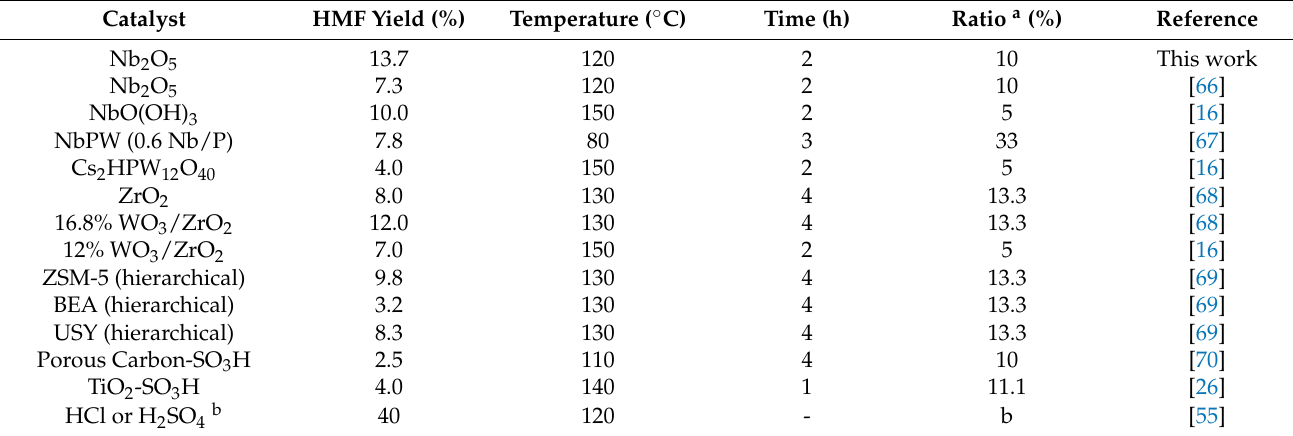
Table 5. A simplified comparison among various catalysts in fructose dehydration to HMF under aqueous solution. Catalyst HMF Yield (%) Temperature ( ◦ C) Time (h) Ratio a (%) Reference Nb 2 O 5